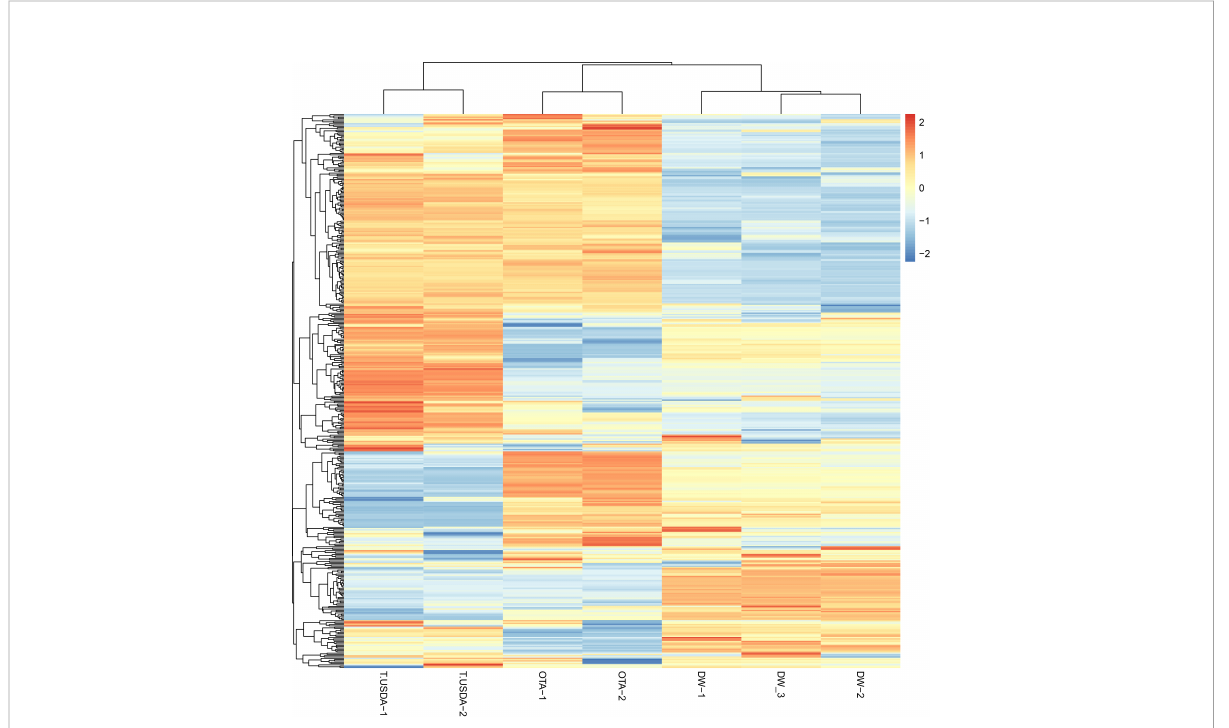
FIGURE 2 Heatmap showing the expression of the miRNAs in the seven samples analyzed. The count matrix was transformed in the log2 scale and normalized according to the library size. The considered samples are shown in the x-axis. In the color scale, orange and blue represent up-and down-expressed miRNAs respectively.